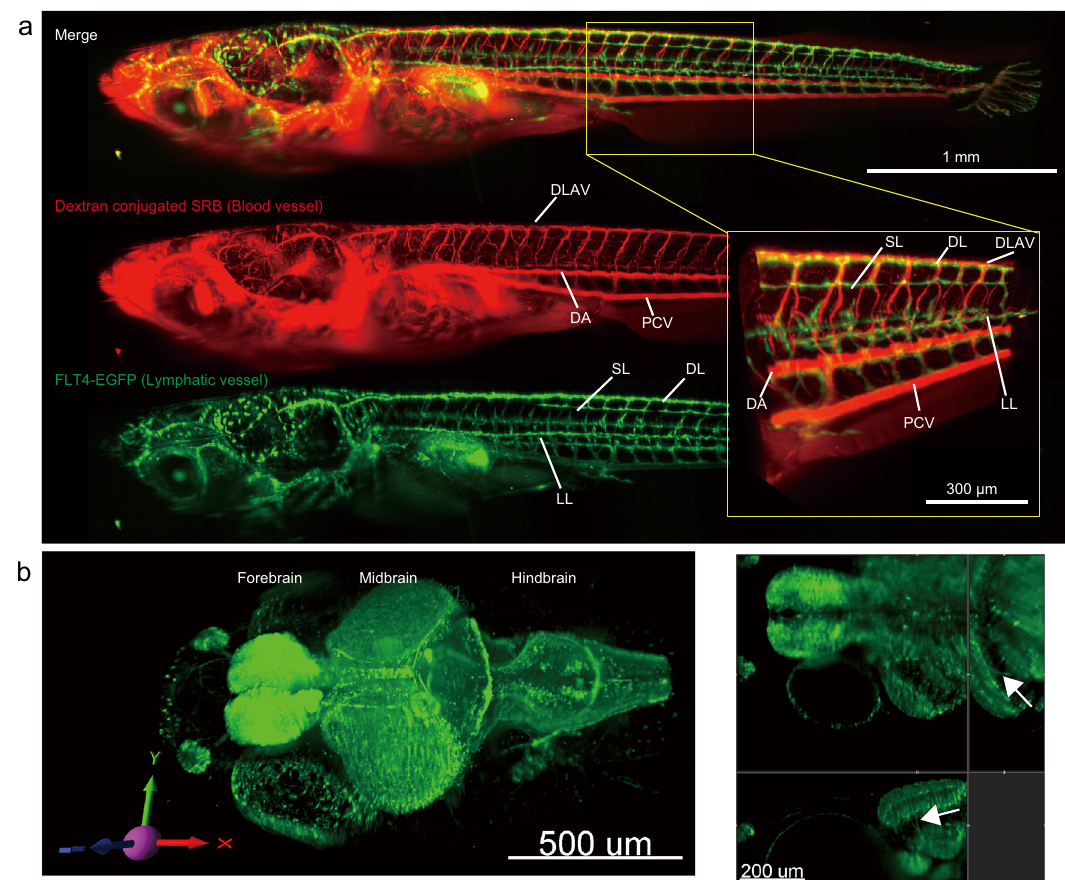
Fig. 5 Whole-body fl uorescent imaging of Medaka larvae. a Three-dimensional reconstructed view of the lymphatic and blood vessels in the whole body of a 2 wph larva. Green shows the EGFP signals from the FLT4-EGFP transgenic strain, and red shows the dextran-conjugated rhodamine signals from the blood vessel. The yellow rectangular shows a magni fi cation view at the body trunk. Exposure time is 100 ms, z -interval is 2 μ m, and xy 1024 × 1024 pixels. n = 3 biologically independent larvae are subjected to the analysis. b Three-dimensional reconstructed view (left) and a sliced view (right) of the whole brain of the Kif5Aa-EGFP strain larva. Exposure time, z -interval, and xy are 100 ms, 2 μ m, and 1024 × 1024 pixels, respectively. n = 5 biologically independent larvae are subjected to the analysis. Abbreviations; DA dorsal aorta, DL dorsal lymphatic, DLAV dorsal longitudinal anastomotic vessel, LL lateral lymphatic, PCV posterior cardinal vein, SL spinal